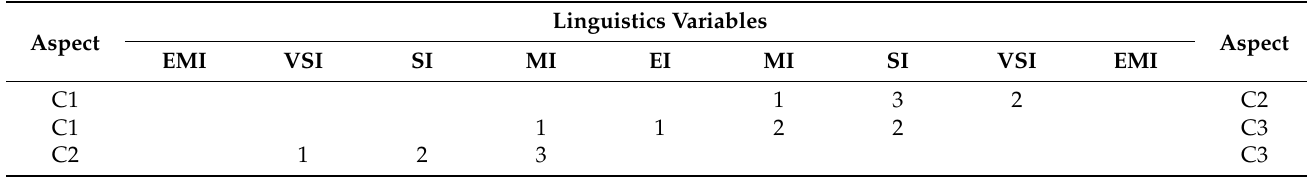
Table 6. The initial comparison matrix of the G-AHP model.